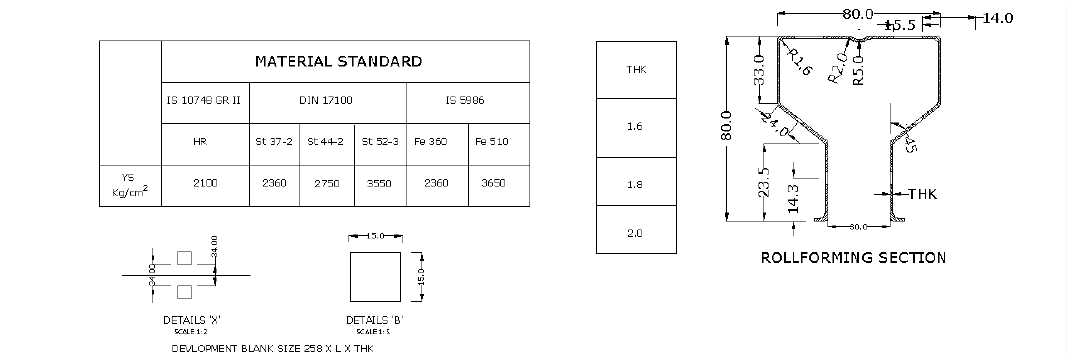
Fig. 1. Medium weight column section 1.6mm, 1.8mm and 2.0 mm thick[12].